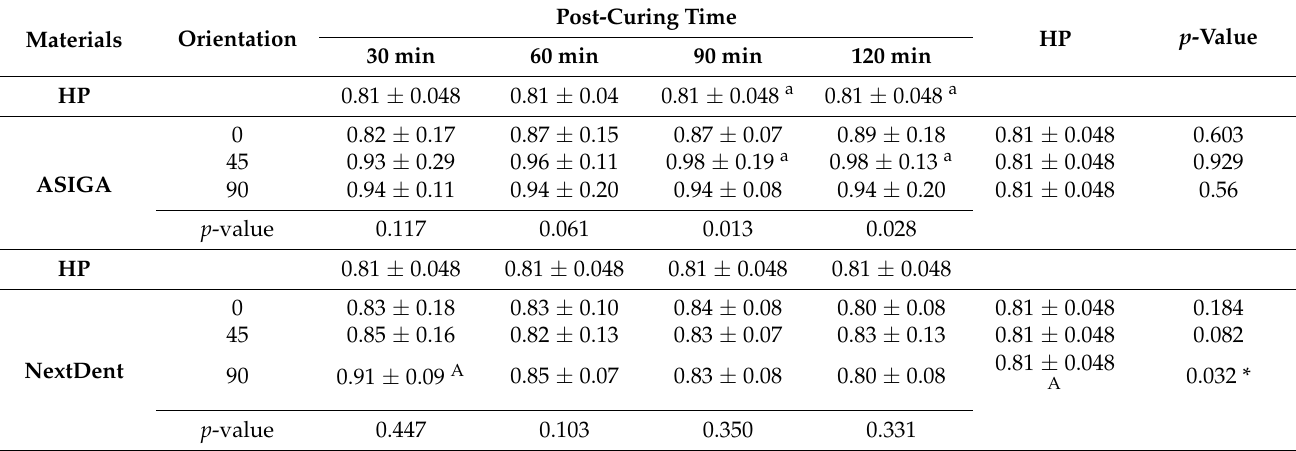
Table 2. Two-way ANOVA for combine effect of orientation and post-curing time on the surface Table 1. Mean, SD, and significance of surface roughness ( µ m) test between groups.